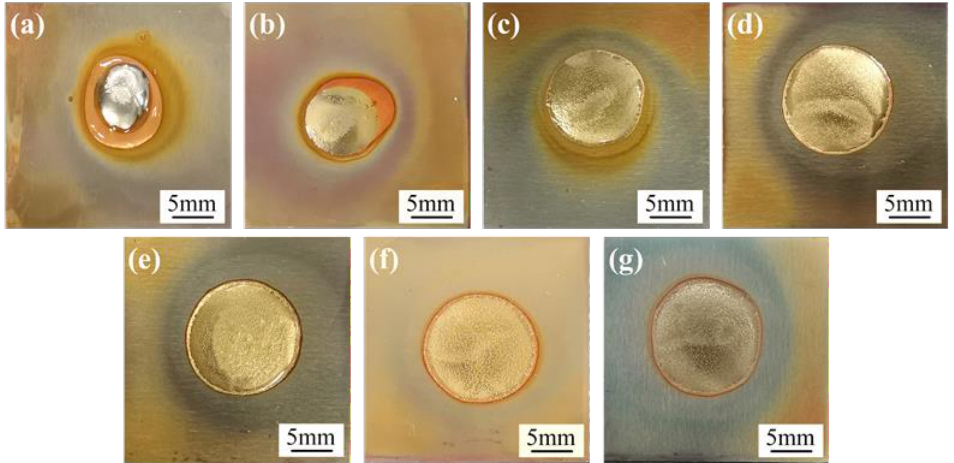
Figure 3. Spreading samples of plain SAC305 and SAC305-xER solder pastes on Cu plates: ( a ) plain SAC305, ( b ) x = 2 wt%, ( c ) x = 4 wt%, ( d ) x = 6 wt%, ( e ) x = 8 wt%, ( f ) x = 10 wt%, ( g ) x = 12 wt%.